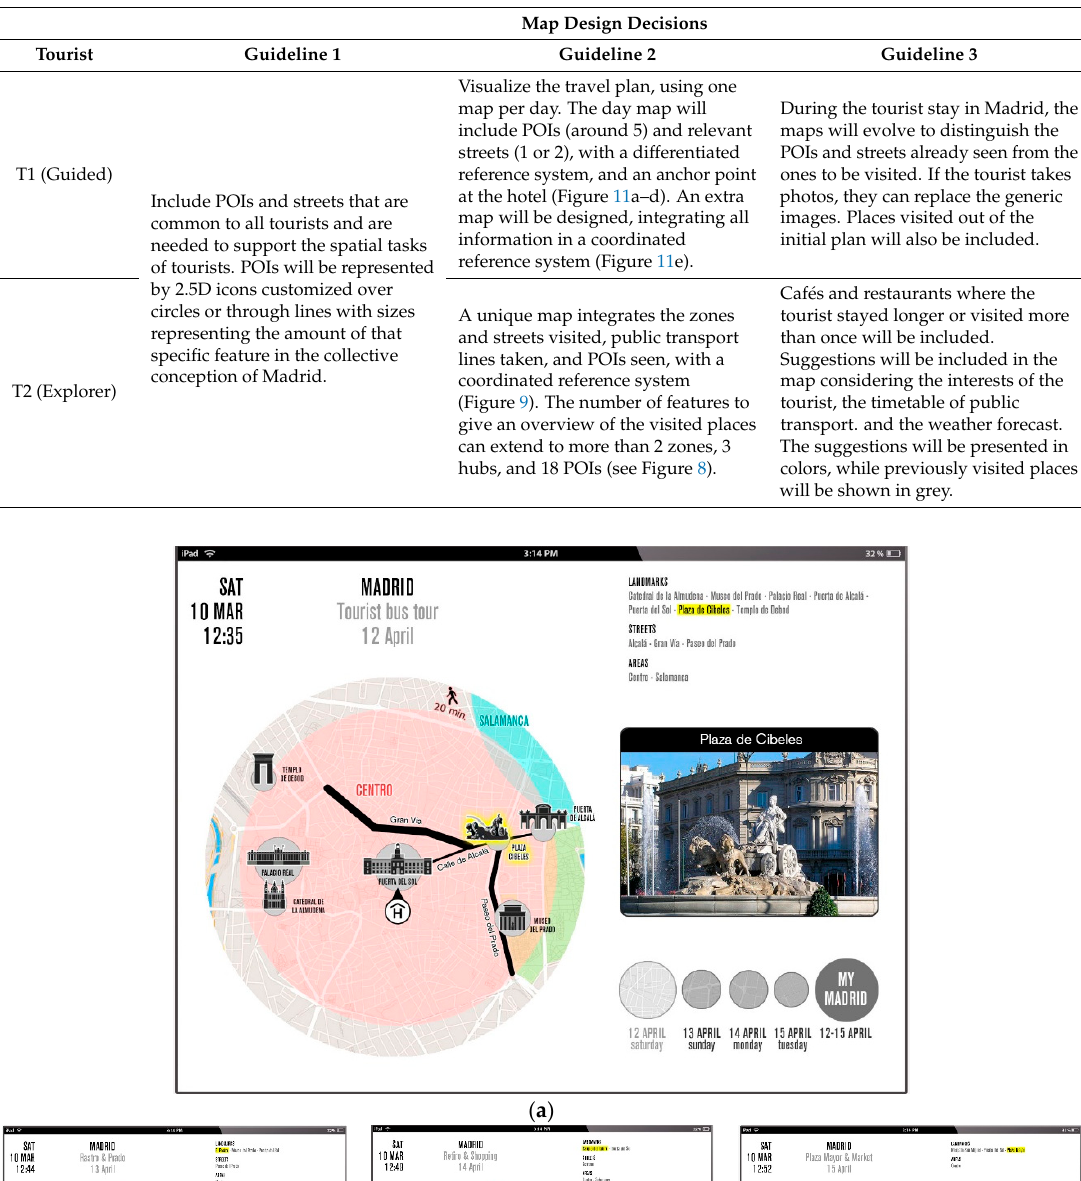
( e ) Figure 11. Maps created for tourist T1 (Guided), illustrating the places to visit daily in Madrid. The pink circle shows the POIs reachable within a 20-min walk from the tourist’s accommodation, located in the city’s “Centro” zone. Maps in ( a – d ) take into account the average number of features and the differentiated reference system of the Guided participant’s sketches (cluster of elements organized around a fixed feature, the hotel). The map in ( e ) summarizes the information on the four previous maps in a coordinated reference system, in order to help user T1 to integrate the information of the daily experiences in a single map. During the stay in Madrid, the maps will evolve to distinguish the POIs and streets already visited, from the ones yet to be seen. If tourist T1 takes photos, they will replace the generic images. Places visited instead of or in addition to the initial plan will also be included.